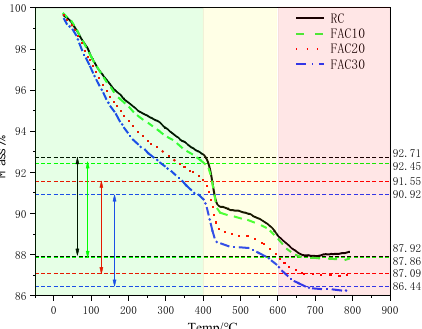
Figure 6. Thermal analysis of pastes at 3